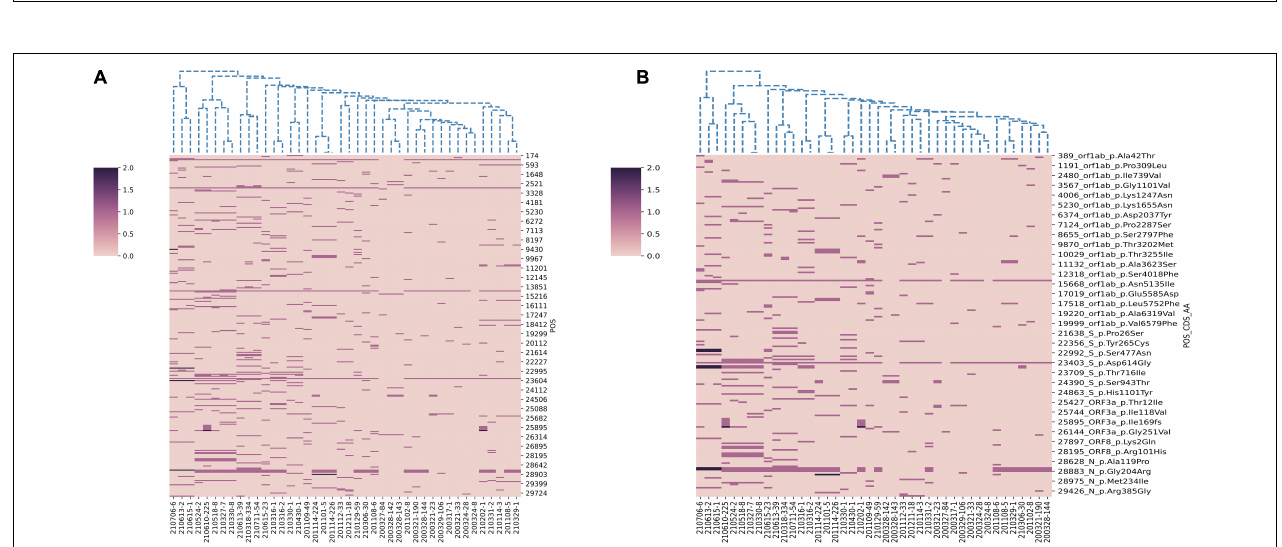
FIGURE 1 | Differences in nucleotide and amino acid substitution in the genomes of SARS-CoV-2 in this study. The sequence of reference genome Wuhan-Hu-1 (GenBank Accession No: MN908947.3) was compared to locate the nucleotide and amino acid positions in the target SARS-CoV-2 genome.